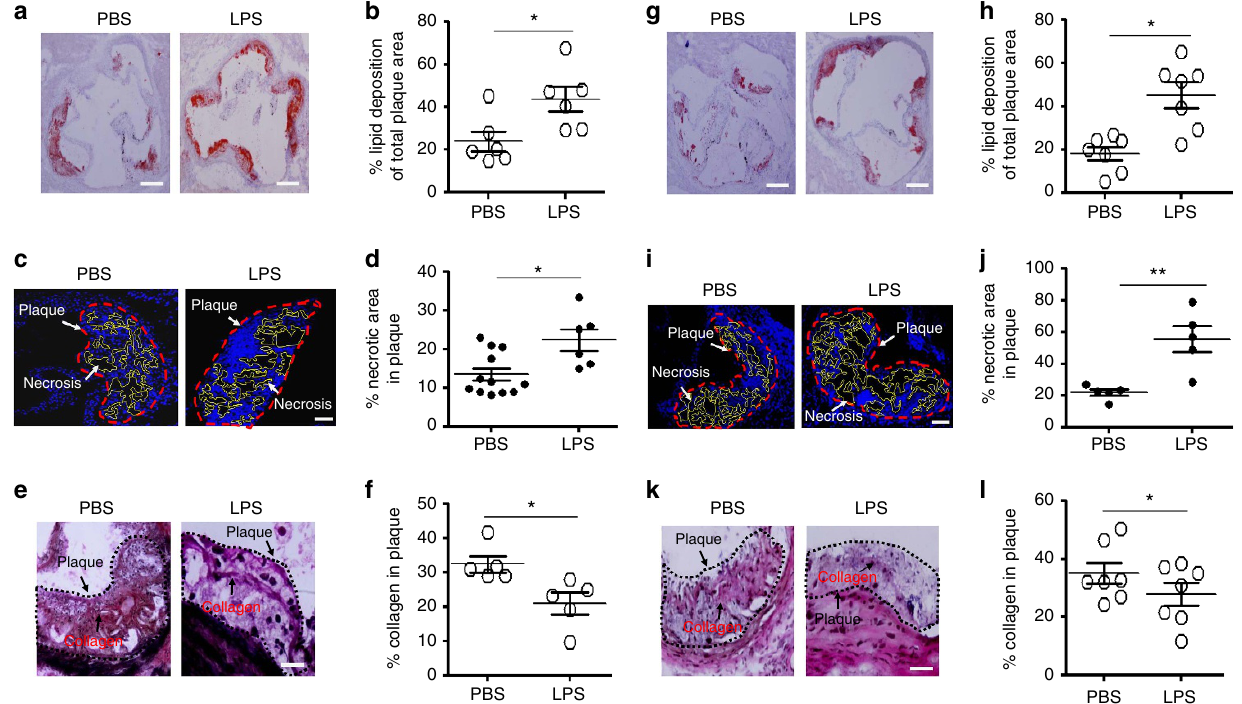
Figure 1 | Subclinical endotoxemia aggravates the progression of atherosclerosis. ( a – f ) ApoE (cid:2) / (cid:2) mice were conditioned with PBS or super-low-dose LPS together with HFD for 8 weeks. ( a ) Representative images of atherosclerotic plaques within aortic root areas stained by Oil Red O. Scale bar, 300 m m. ( b ) Ratios of the lipid deposition area among the total atherosclerotic plaque area within the aortic root from PBS mice ( n ¼ 6) and super-low-dose LPS-conditioned mice ( n ¼ 6). ( c ) Representative images of necrotic core areas within the aortic roots. Scale bar, 100 m m. ( d ) Ratios of the necrotic area among the total atherosclerotic plaque area from PBS ( n ¼ 12) and super-low-dose LPS-conditioned ( n ¼ 6) mice. ( e ) Representative images of collagen containing areas within aortic roots. Scale bar, 100 m m. ( f ) Ratios of the collagen-containing area among the total atherosclerotic plaque area within the aortic root from PBS ( n ¼ 5) and super-low-dose LPS-conditioned ( n ¼ 5) mice. ( g – l ) ApoE (cid:2) / (cid:2) mice were pre-conditioned with PBS or super-low-dose LPS for 4 weeks together with HFD, followed by HFD feeding only for an additional 4 weeks. ( g ) Representative images of atherosclerotic plaques within aortic root areas stained by Oil Red O. Scale bar, 300 m m. ( h ) Quantification of the lipid deposition area as a percentage of the total atherosclerotic plaque area within the aortic root from PBS ( n ¼ 7) and super-low-dose LPS-conditioned ( n ¼ 7) mice. ( i ) Representative images of necrotic core areas within the aortic roots. Scale bar, 100 m m. ( j ) Ratios of the necrotic area among the total atherosclerotic plaque area within the aortic root from PBS ( n ¼ 5) and super-low- dose LPS-conditioned ( n ¼ 5) mice. ( k ) Representative images of collagen containing areas within aortic roots. Scale bar, 100 m m. ( l ) Ratios of the collagen containing area among the total atherosclerotic plaque area within the aortic root from PBS ( n ¼ 7) and super-low-dose LPS-conditioned ( n ¼ 7) mice. Error bars show means ± s.e.m. All data are representative of at least two similar experiments. * P o 0.05 and ** P o 0.01; Student’s t